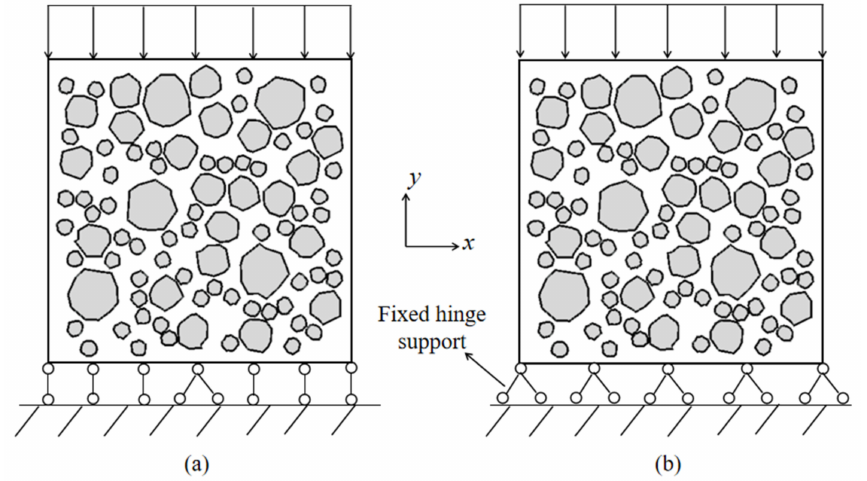
Figure 8. Boundary conditions and loading mode of RAC. ( a ) Loading method 1; ( b ) Loading method